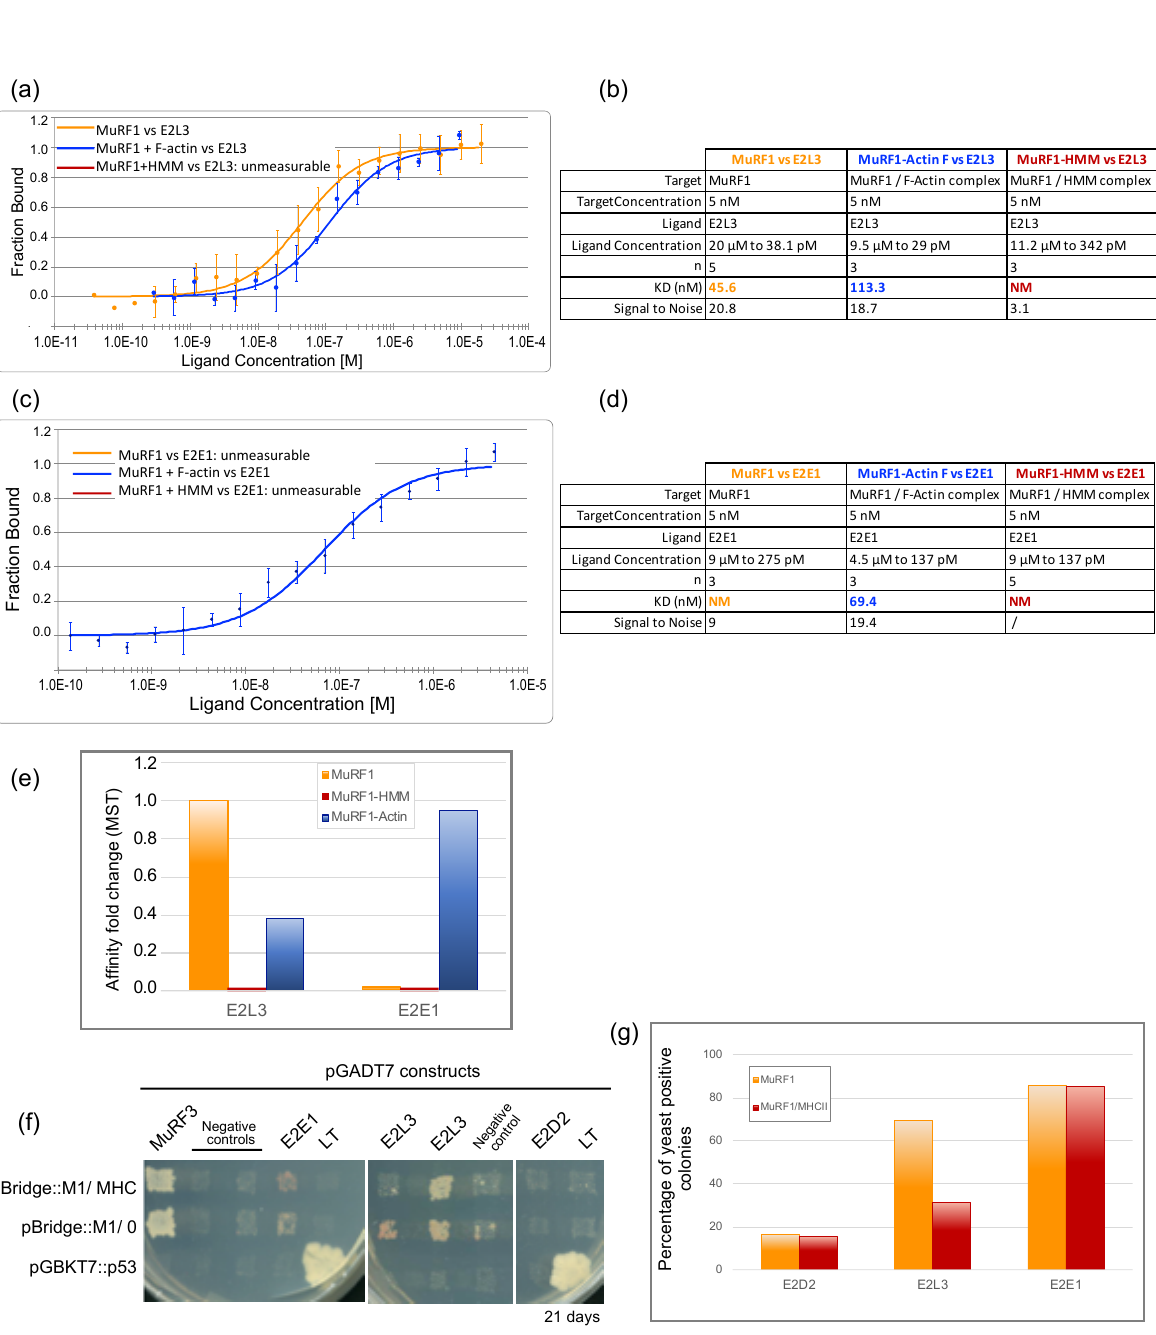
Figure 5. Impact of substrates on MuRF1–E2 interaction. ( a ) Dose–response curves for MuRF1–E2L3 interaction in presence or absence of substrates, a-actin or HMM (myosin). ( b ) Dataset overview of the photobleaching experiments performed with E2L3 in ( a ). ( c ) Dose–response curves for MuRF1–E2E1 interaction in presence or absence of substrates. ( d ) Dataset overview of the photobleaching experiment performed with E2E1 in ( c ). ( e ) Affinity change based on data presented in ( a – d ). ( f ) Impact of MHCIIa (residues 1–255) on the interaction between MuRF1 and E2L3, E2E1 or E2D2, determined by yeast-three-hybrid (Y3H) experiments. Diploid yeast colonies were replicated on selection plates (medium lacking leucine, tryptophan and histidine and supplemented with 20 mM Aureobasidin A and 2.5 mM 3-Amino-1,2,4-triazole), allowing the readout of interaction occurrence. Four independent transformations were performed, and 10 to 16 colonies were analyzed for each interaction studied. The strong interactions MuRF1–MuRF3 and p53–Large-T served as positive controls. Representative results are shown; two different “E2L3 + MuRF1/MHC” clones are presented to illustrate that MHC impacted the growth of 50% of the clones in contrast to the “E2L3 +MuRF1” clones. ( g ) Data from Y3H experiments were presented as percentage of clones that have grown on selective media (see Section 2 for details). Ten to 16 clones were analyzed for each